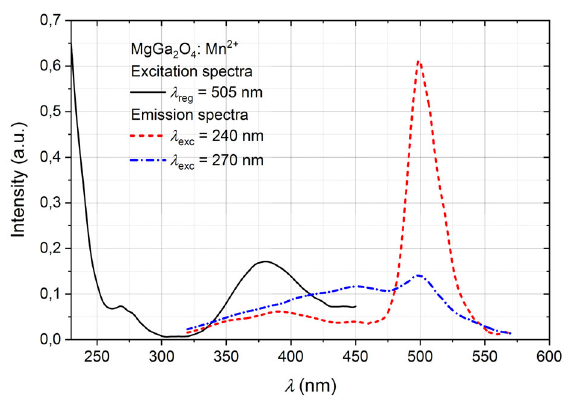
Fig. 8 PL excitation (black line) and emission spectra (red and blue lines) in MgGa 2 O 4 :Mn 2+ ceramic sample.